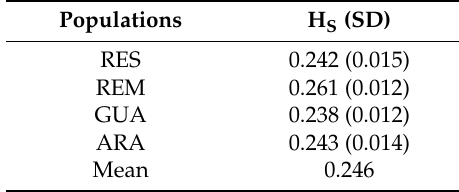
Table 3. Within-population genetic diversity index H S calculated for the four studied populations of Avicennia schaueriana and its mean value. RES—restored plants in Mauá Beach; REM—remnant plants in Mauá Beach; GUA—ESEC Guanabara; ARA—Araçá Bay; and SD—standard deviation.